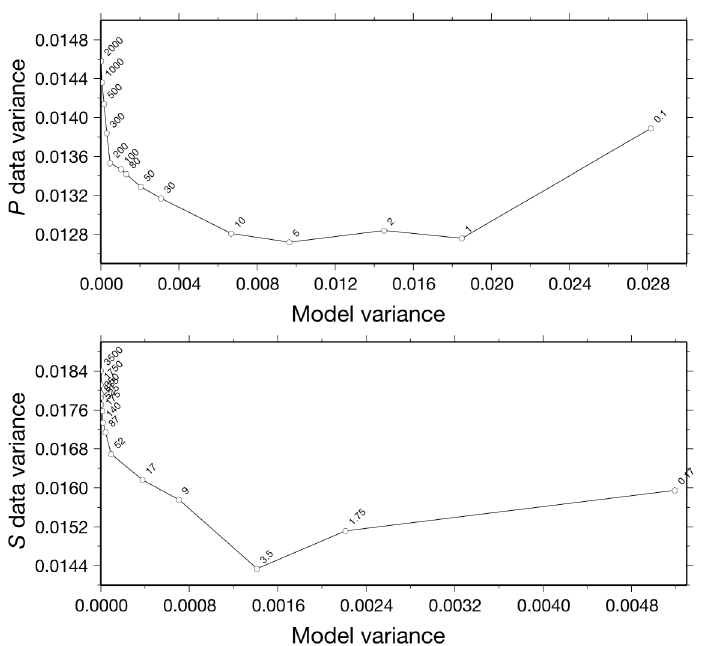
Fig. 2. Trade-off curve between variances of the model and P + S data weighted for the model. The trade-off curve is determined after the application of different damping